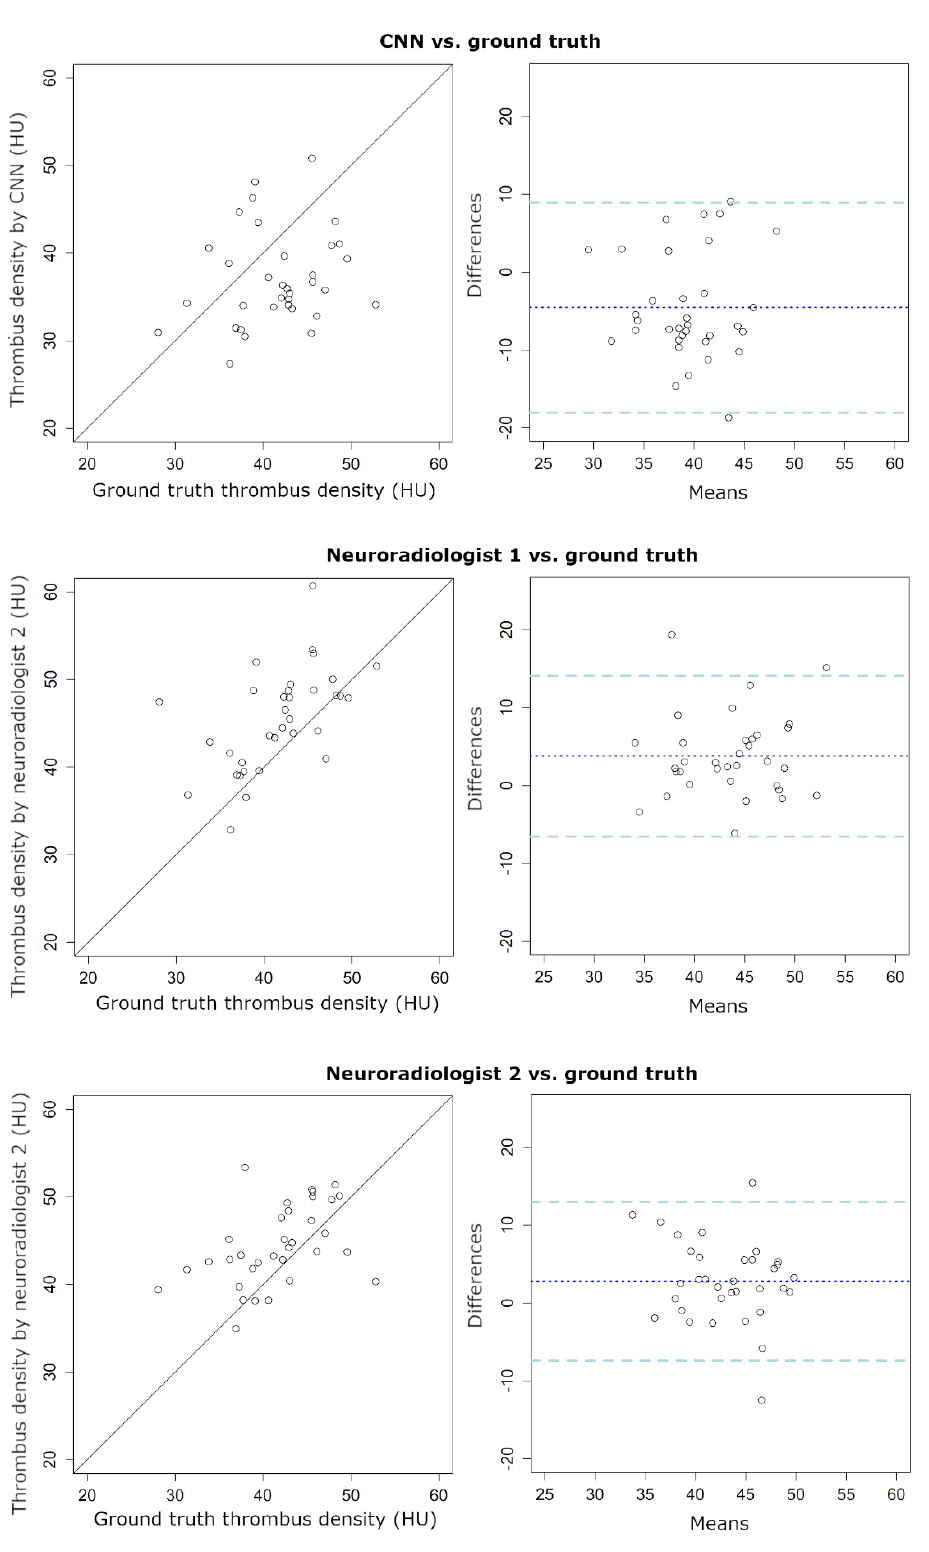
Figure 4. Scatter ( Left ) and Bland–Altman ( Right ) plots for thrombus density. The dotted line and dashed lines within the Bland–Altman plot represent the bias and limits of agreements, respectively.